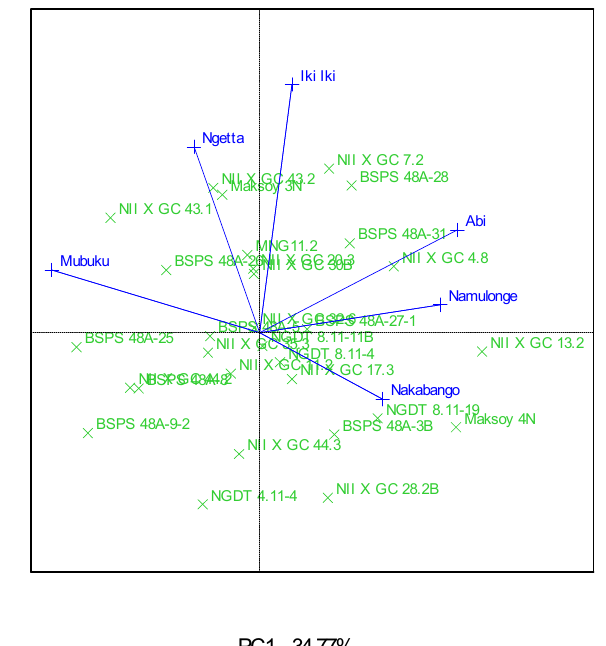
Figure 3. GGE scatterplot based on symmetrical scaling for the “which-won-where” pattern of 30 soybean genotypes evaluated in six locations.